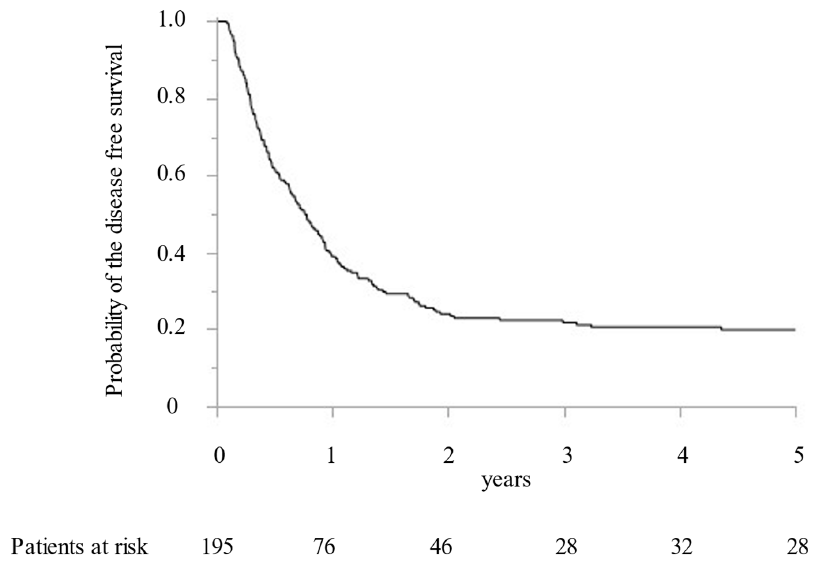
Figure 2. The Kaplan ‒ Meier curve of the disease-free survival following microwave ablation.